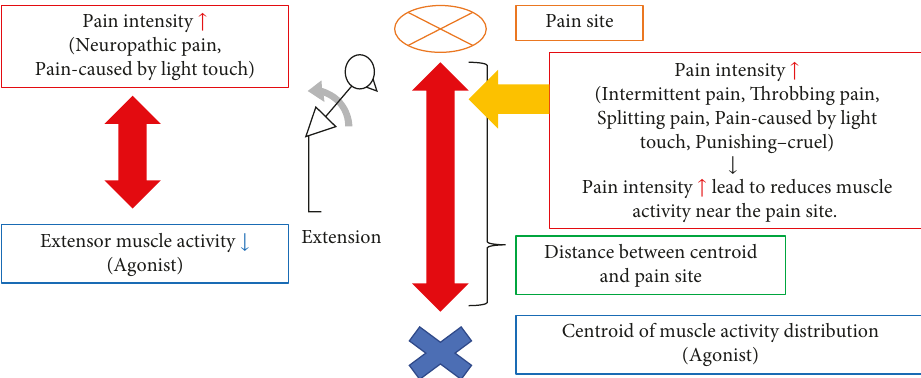
Figure 3: Explanatory model of interaction between pain intensity, pain site, and muscle